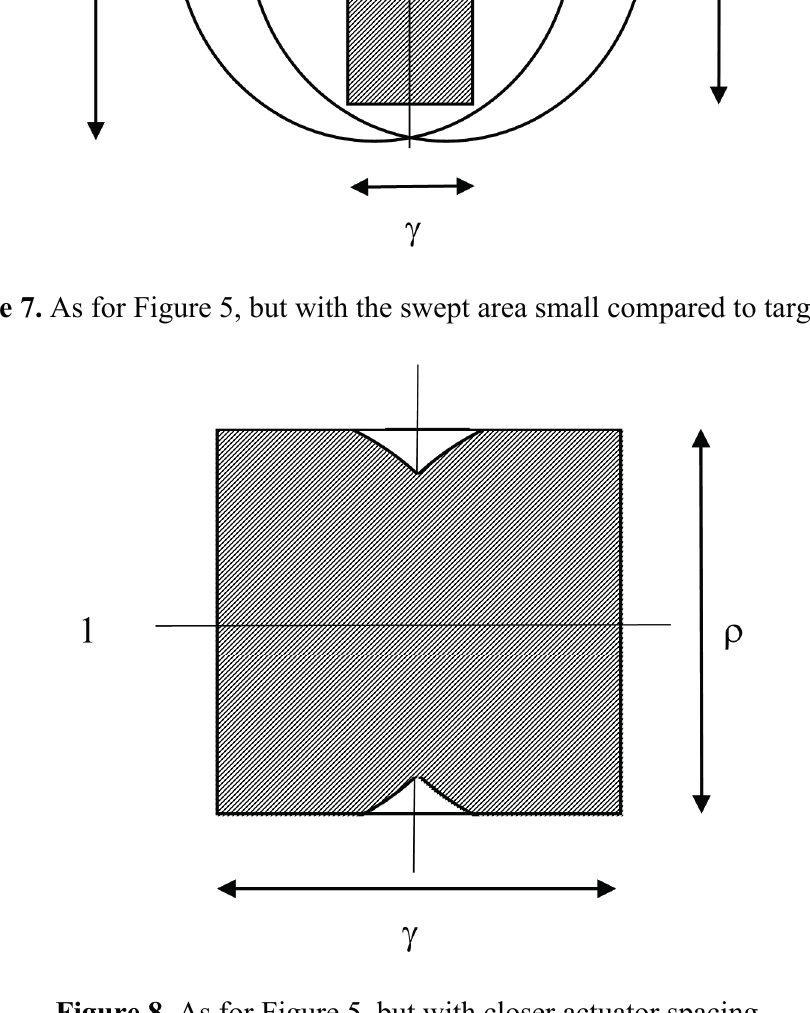
Figure 8. As for Figure 5, but with closer actuator